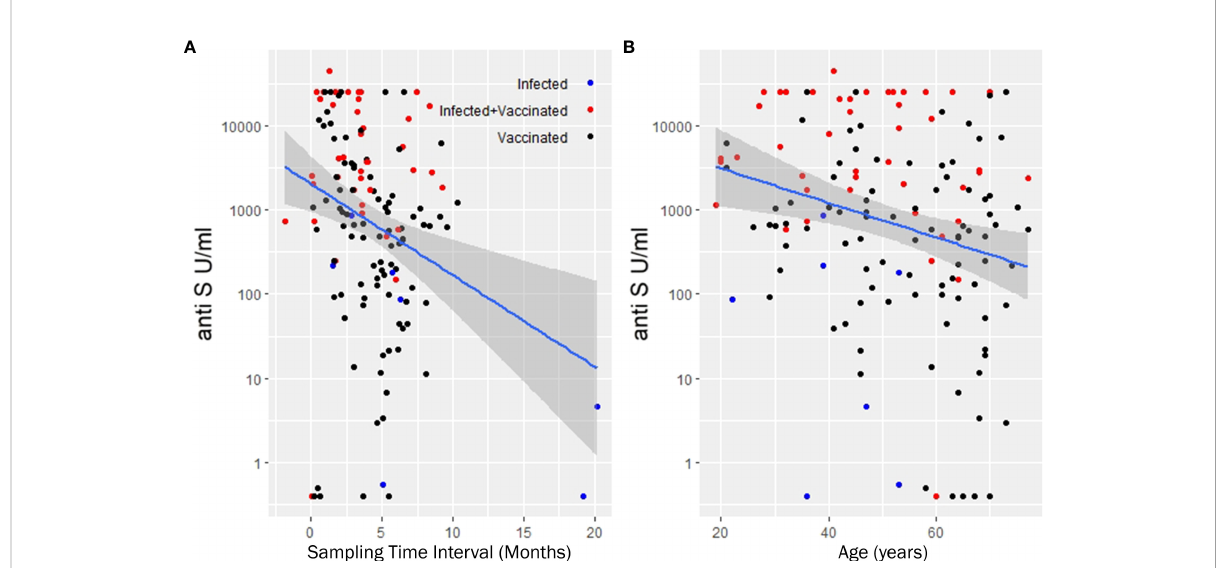
FIGURE 2 Least squares trend lines of anti-S antibody titers vs time since last vaccination (A) and anti-S antibody titers vs. age of recipients (B) . (A, B) show the antibody titers in the entire study population. The lines are population regression lines unadjusted for any covariates. The shaded bands represent the pointwise 95% con fi dence interval on the fi tted values. We used multiple linear regression to eliminate the covariate effects and get more precise numerical estimate of the slopes. Accordingly, anti-S antibody levels decreases monthly by 25% and each additional year corresponds to 4 percent decrease in the initial anti-S antibody levels. Samples taken from the three subcohort groups (infected, infected but later vaccinated, vaccinated but without record of infection are denoted with different